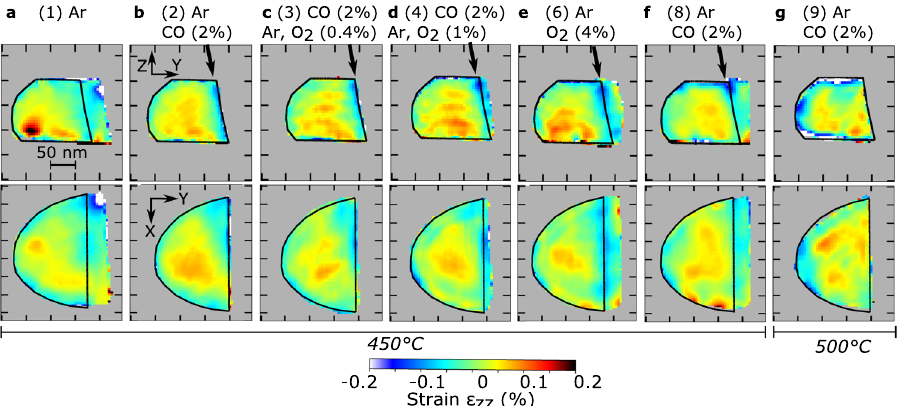
Fig. 4 Out-of-plane strain evolution. Out-of-plane strain maps at the center of the reconstructed crystal (at 450 °C under a Ar, b Ar and CO (2%), c Ar, CO (2%) and O2 (0.4%), d Ar, CO (2%) and O2 (1%), e Ar and O2 (4%), f Ar and CO (2%) and at 500°C under g Ar and CO (2%)). The dotted black contours are guide for the eyes and delimit the shape of the crystal measured at condition (2): Ar and CO (2%) at 450 °C. Tick spacing corresponds to 50